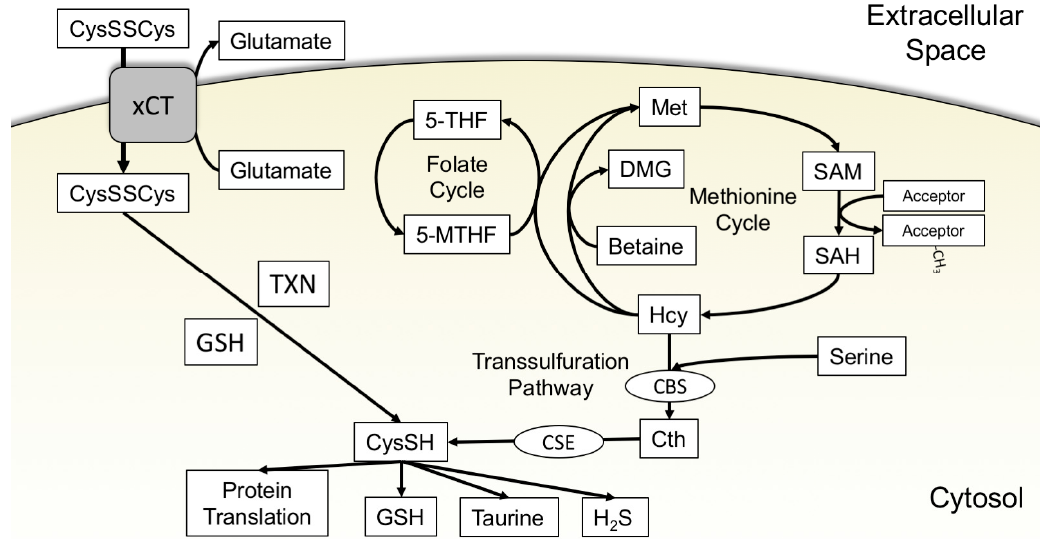
Figure 1. Acquisition of cysteine from extracellular cystine through xCT and de novo production of cysteine through the transsulfuration pathway. (Left) Extracellular cystine is transported into the cell through xCT while glutamate is exported. Thioredoxin or glutathione reduce cystine to cysteine, which is subsequently used for the synthesis of proteins, glutathione, and other sulfur ‐ containing molecules. (Right) The de novo cysteine synthesis pathway (transsulfuration) requires the sulfur group from methionine. In the methionine cycle, methionine is adenosylated to produce SAM. SAM donates a methyl group to a methyl acceptor (protein, RNA, or DNA) to generate SAH. SAH hydrolase (not shown) generates Hcy from SAH. Hcy can regenerate methionine by accepting a methyl group from betaine or 5 ‐ MTHF from the folate cycle. Hcy can alternatively exit the methionine cycle via its condensation with serine by CBS in the first step of the transsulfuration pathway to produce Cth. Cth is subsequently hydrolyzed by CSE to ammonia (not shown), α‐ ketobutyrate (not shown), and cysteine. 5 ‐ MTHF: 5 ‐ tetramethylhydrofolate, 5 ‐ THF: 5 ‐ tetrahydrofolate, Cth: